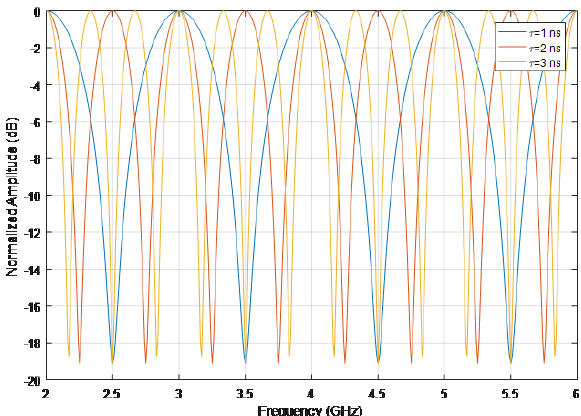
Figure 5. Normalized amplitude transfer function for a two-ray model and different differential delays.